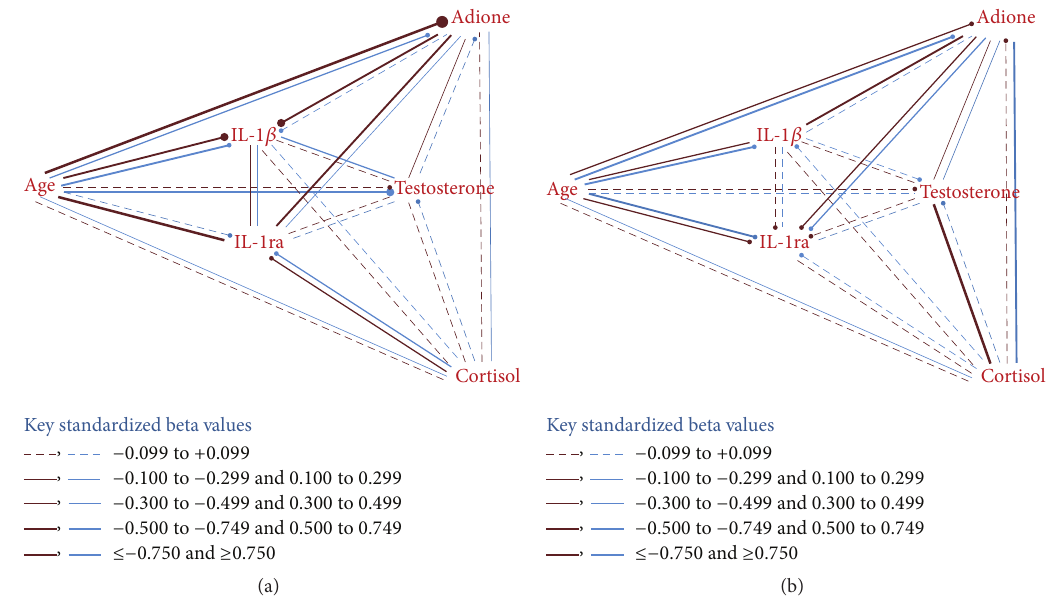
Figure 1: (a) Female pathway correlations showing stronger associations of age and androstenedione with the immunologic markers in pre- RA versus CN, but greater negative association of age with testosterone in CN subjects. (b) Male pathway correlations showing stronger associations of cortisol with testosterone in pre-RA versus CN, but greater association of cortisol with androstenedione in CN subjects. (a) Females: RA versus CN (pre-RA: top or left red, CN: bottom or right blue). (b) Males: RA versus CN (pre-RA: top or left red, CN: bottom or right blue).